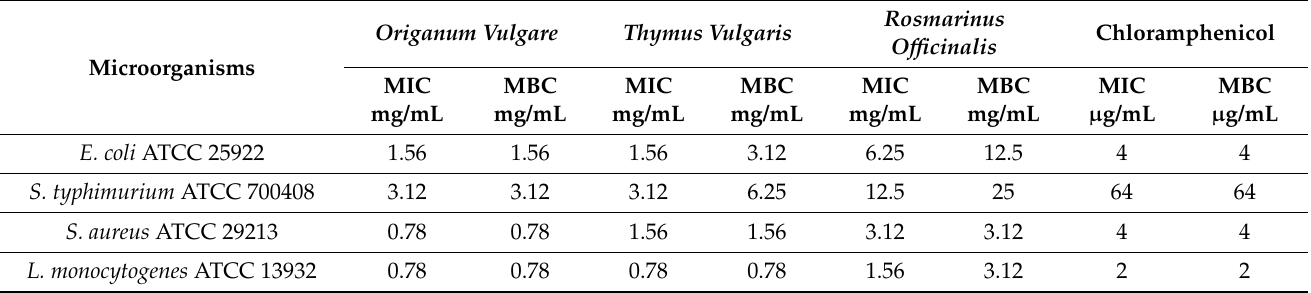
Table 7. MIC and MBC values of Origanum vulgare, Thymus vulgaris , and Rosmarinus officinalis essential oils